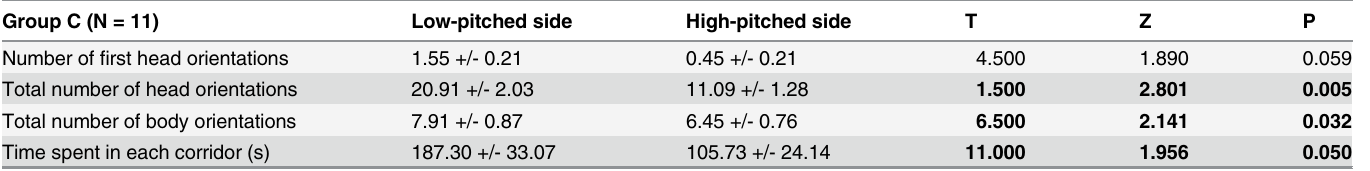
Table 7. Mares ’ responses to playbacks (Experiment